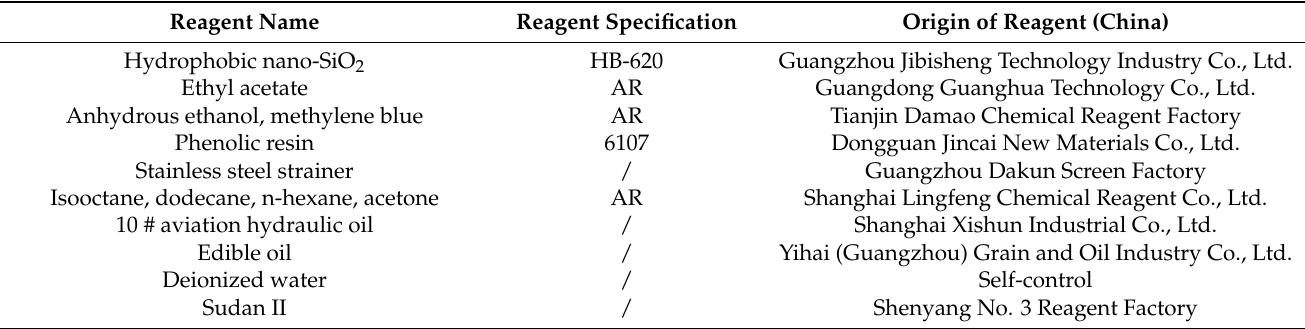
Table 1. Main experimental drugs.